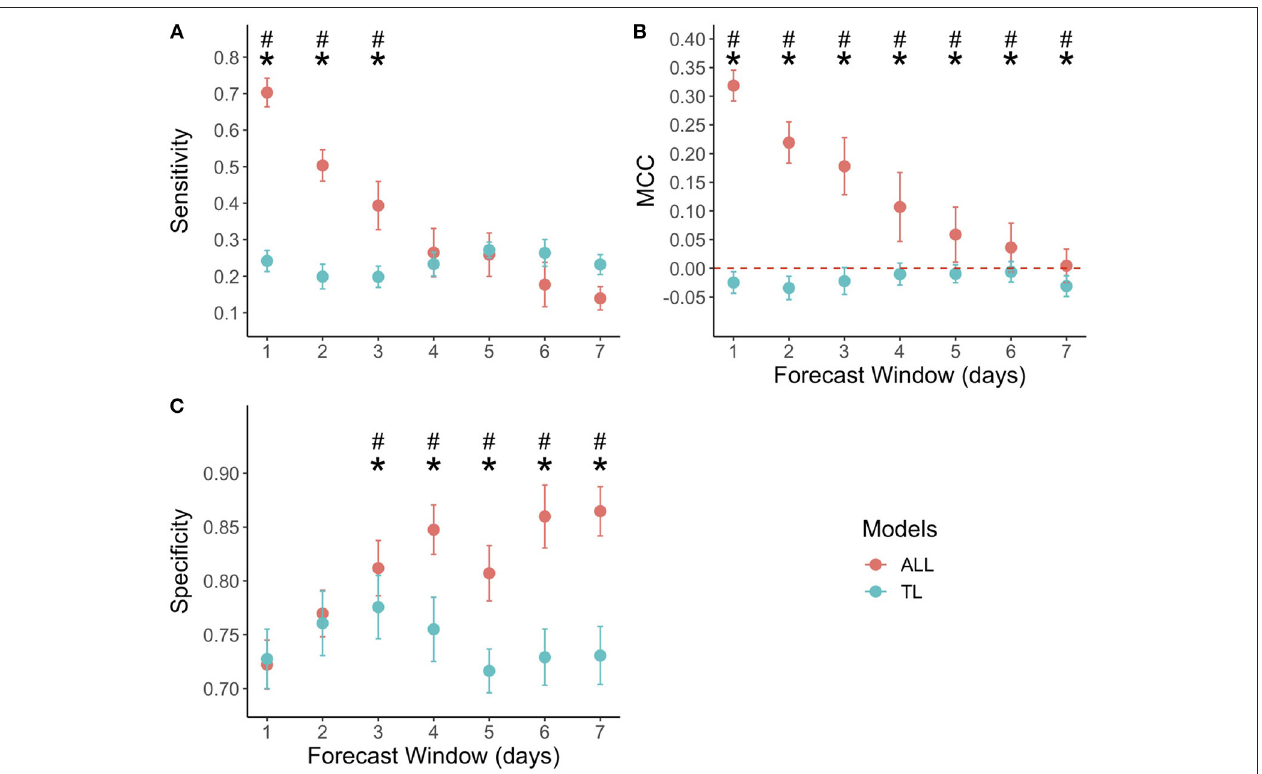
FIGURE 3 | Evaluation metrics scores for both the ALL forecasting models (red dots) and TL forecasting models (blue dots). The x-axis displays the model forecasting window (from 1 to 7 days), while the y-axis presents in (A) the sensitivity, (B) Matthews Correlation Coefficient (MCC), and (C) specificity. The (*) symbol indicates a significant positive difference for the ALL forecasting models compared to the TL forecasting models ( p < 0.01), as determined by paired T -test performed on each individual forecasting window, while the (#) symbol indicates positive large Cohen effect sizes for the ALL forecasting models compared to the TL forecasting models (d > 1). The red dotted line on graph (B) indicates a MCC of zero, corresponding to the performance of a model making predictions randomly. Note that the y-axis of each graph are all on different scales to better appreciate the difference between the two types of models for every